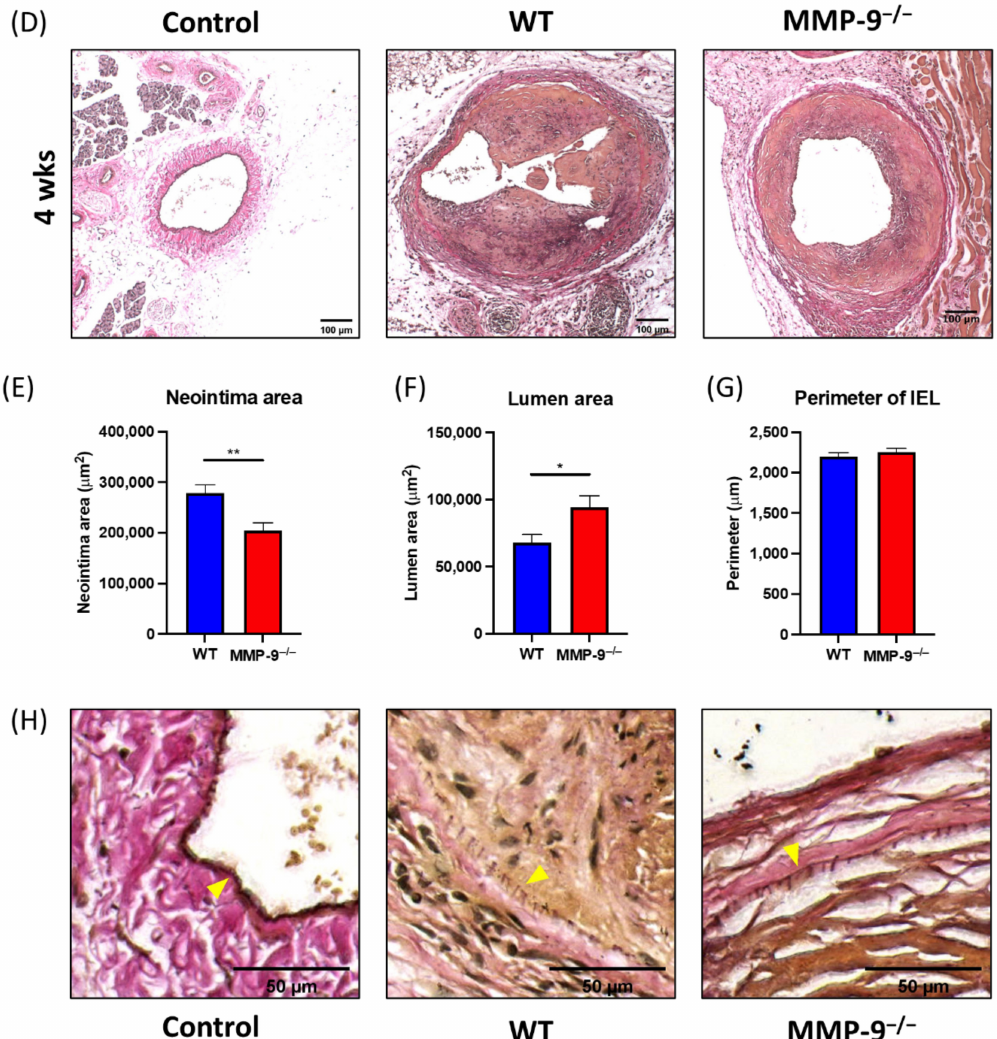
Figure 3. Matrix metalloproteinase 9 (MMP-9) knockout attenuated neointima formation and increased lumen size in arteriovenous (AV) fistula venous segment. ( A ) AV fistula was created in both wild-type (WT) and MMP-9 − / − mice to examine the influence on AV fistula. ( B , C ) Chronic kidney disease was successfully induced in both WT and MMP-9 − / − mice with significantly elevated serum blood urea nitrogen (BUN) and creatinine. ( D ) Morphometric analysis was done after elastin staining, scale bar = 100 µ m. ( E ) Neointima size decreased and ( F ) lumen area enlarged after MMP-9 knockout ( p = 0.0013 and 0.0116, respectively). ( G ) Internal elastic lamina (IEL) perimeter was not significantly different between WT and MMP-9 − / − mice. ( H ) IEL structure was examined under high magnification, and loose structure was found in both WT and MMP-9 − / − mice AV fistula venous segment, scale bar = 50 µ m. No visible detrimental effect was detected after MMP-9 knockout. * p < 0.05, ** p < 0.01. Data presented as mean ± SEM. Data analyzed by Student’s t -test one-way, n = 6–7 in each